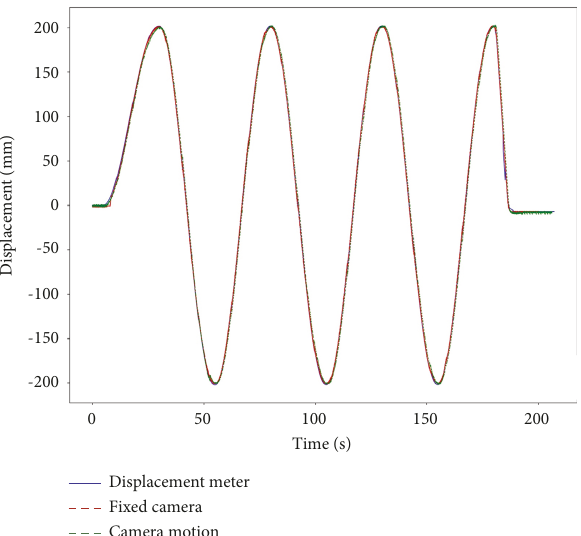
Figure 9: Displacement time history of 250% shear deformation of isolated bearing achieved using various displacement measurement